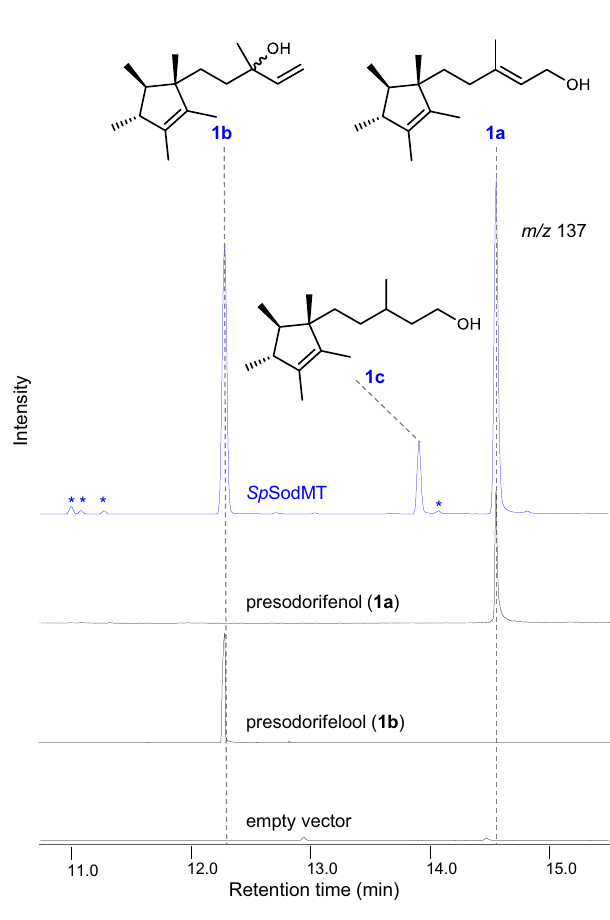
Fig. 2 | Production of presodorifenyl diphosphate in yeast. Expression of Sp SodMTinyeastresultedintheproductionofthreealcohols, 1a , 1b and 1c (blue), which were isolated and identi fi ed as presodorifenol, presodorifelool, and 2,3- dihydro-presodorifenol, respectively. Chromatograms in black show puri fi ed and structurally-characterized 1a and 1b compounds. None of these compounds was produced by yeast cells carrying the empty vector (also in black). Traces of four other compounds (*) were